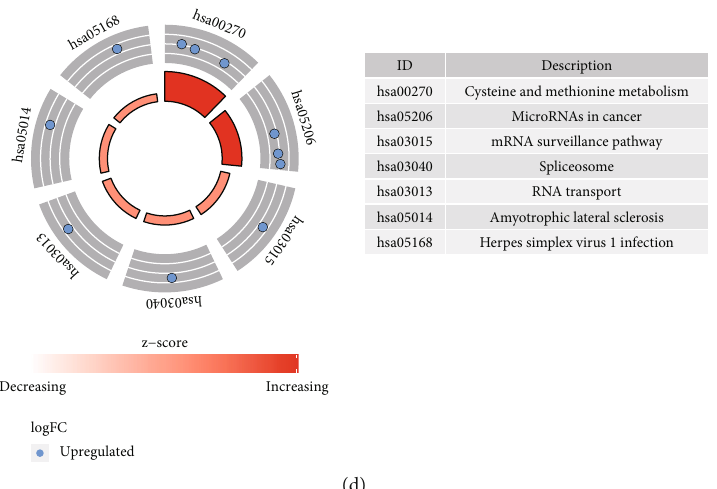
Figure 2: Enrichment plots of twelve m 5 C RNA methylation-related genes by performing GSEA. (a) GO enrichment analysis of twelve m 5 C RNA methylation-related genes in the TCGA-KIRC cohort. (b) KEGG pathway analysis of twelve m 5 C RNA methylation-related genes in the TCGA-KIRC